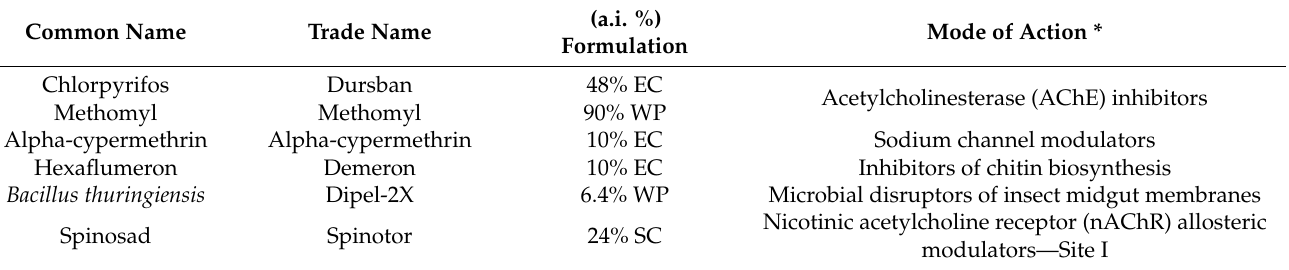
Table 1. Used insecticides and their